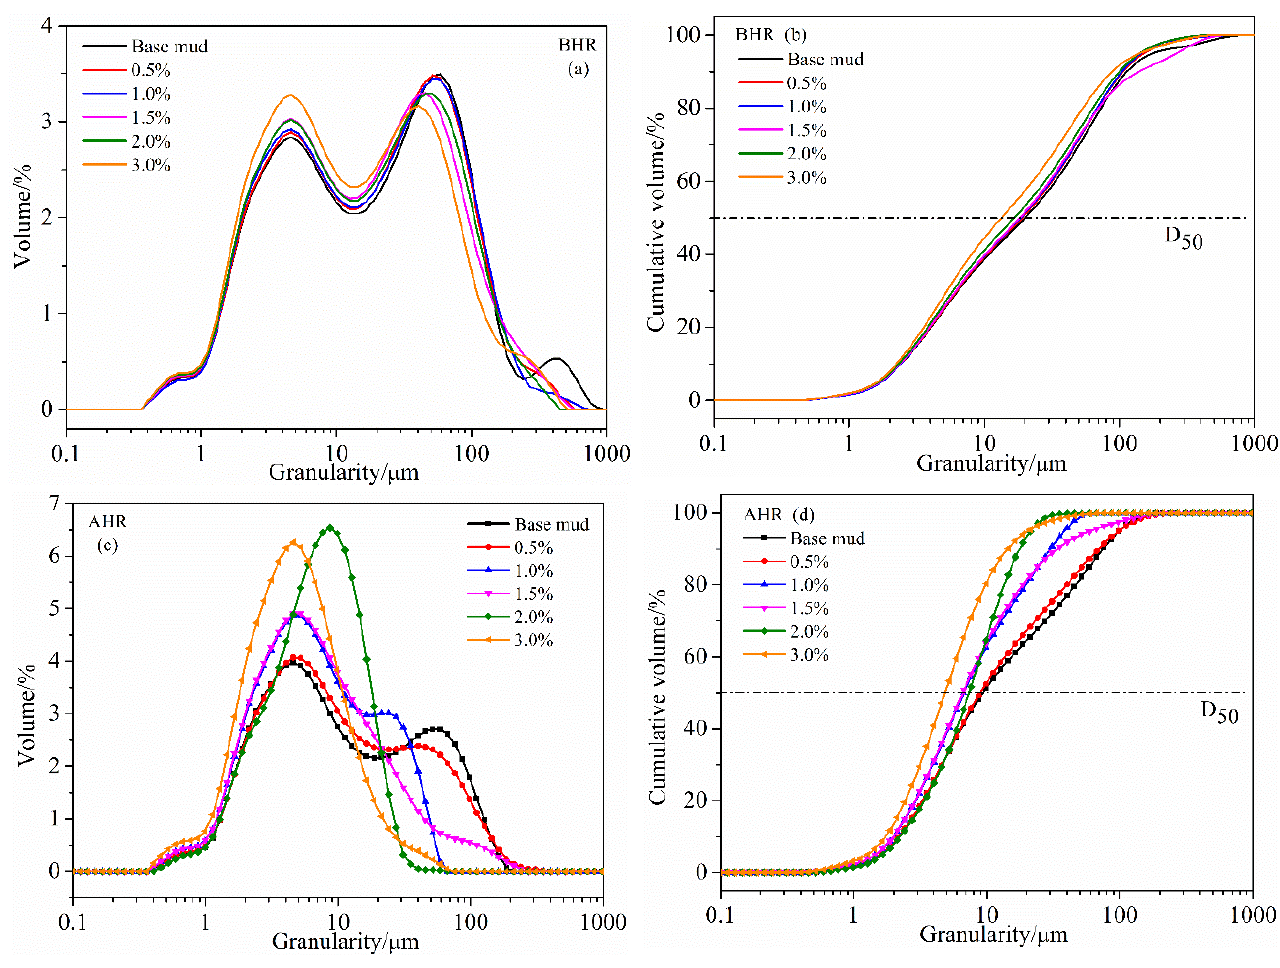
Figure 8. Particle size distribution of drilling fluids before and after aging: ( a ) granularity distribution BHR, ( b ) volume cumulative distribution BHR, ( c ) granularity distribution AHR, and ( d ) volume cumulative distribution AHR). Table 2. Particle size of the drilling fluid before and after aging.